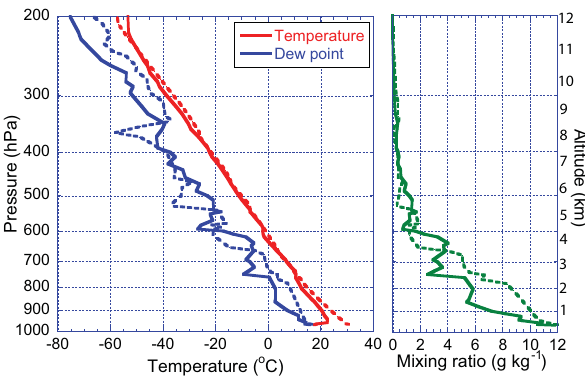
Figure 5. Radiosonde release for Aberdeen, South Dakota, for 29 June 12:00Z (solid) and 30 June 00:00Z (dashed).